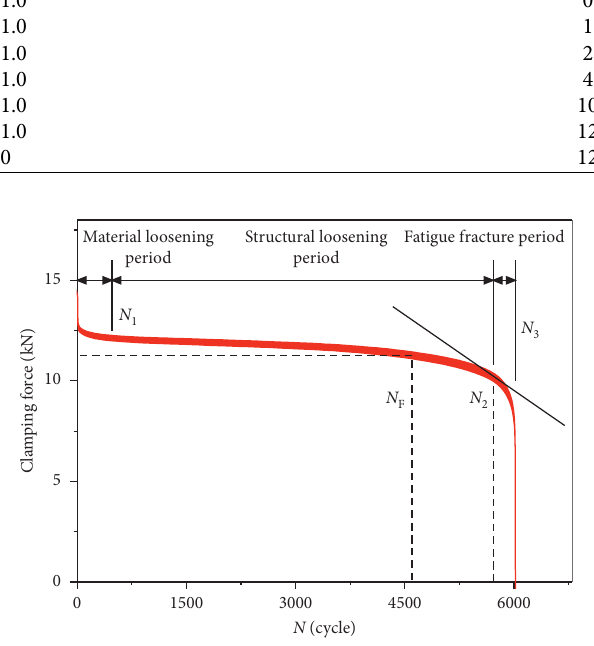
Figure 2: Typical clamping force recession